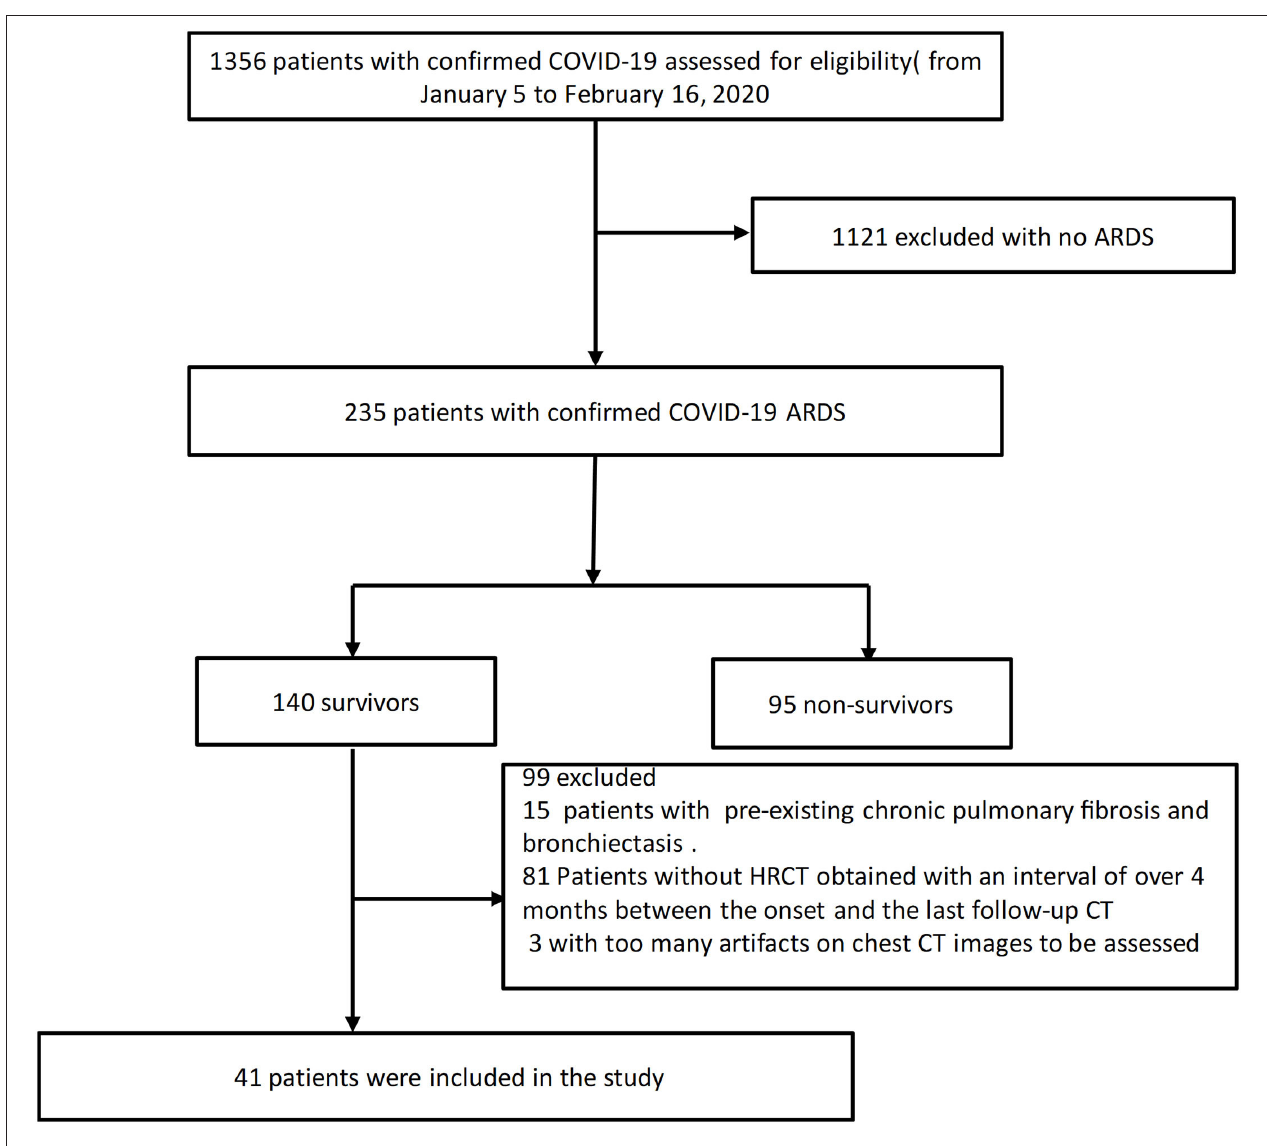
FIGURE 1 | Study flow